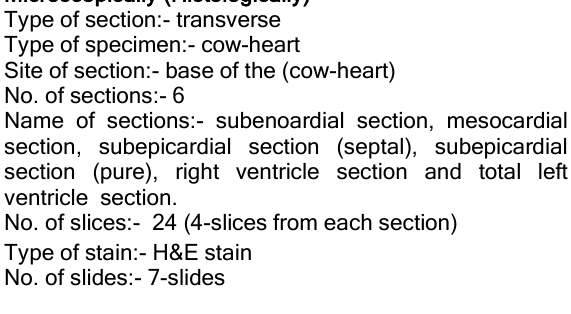
Figure 9. A transverse section passing throws the heart base, showing the layers of left ventricular wall and right ventricular single layer wall.